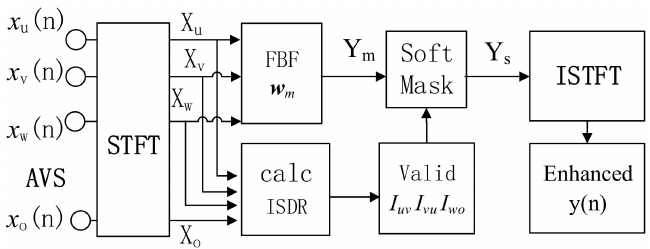
Figure 4. Block diagram of our proposed AVS-SMASK algorithm (STFT: Short-Time Fourier Transform; FBF: a fixed beamformer; ISTFT: inverse STFT; y(n): enhanced target